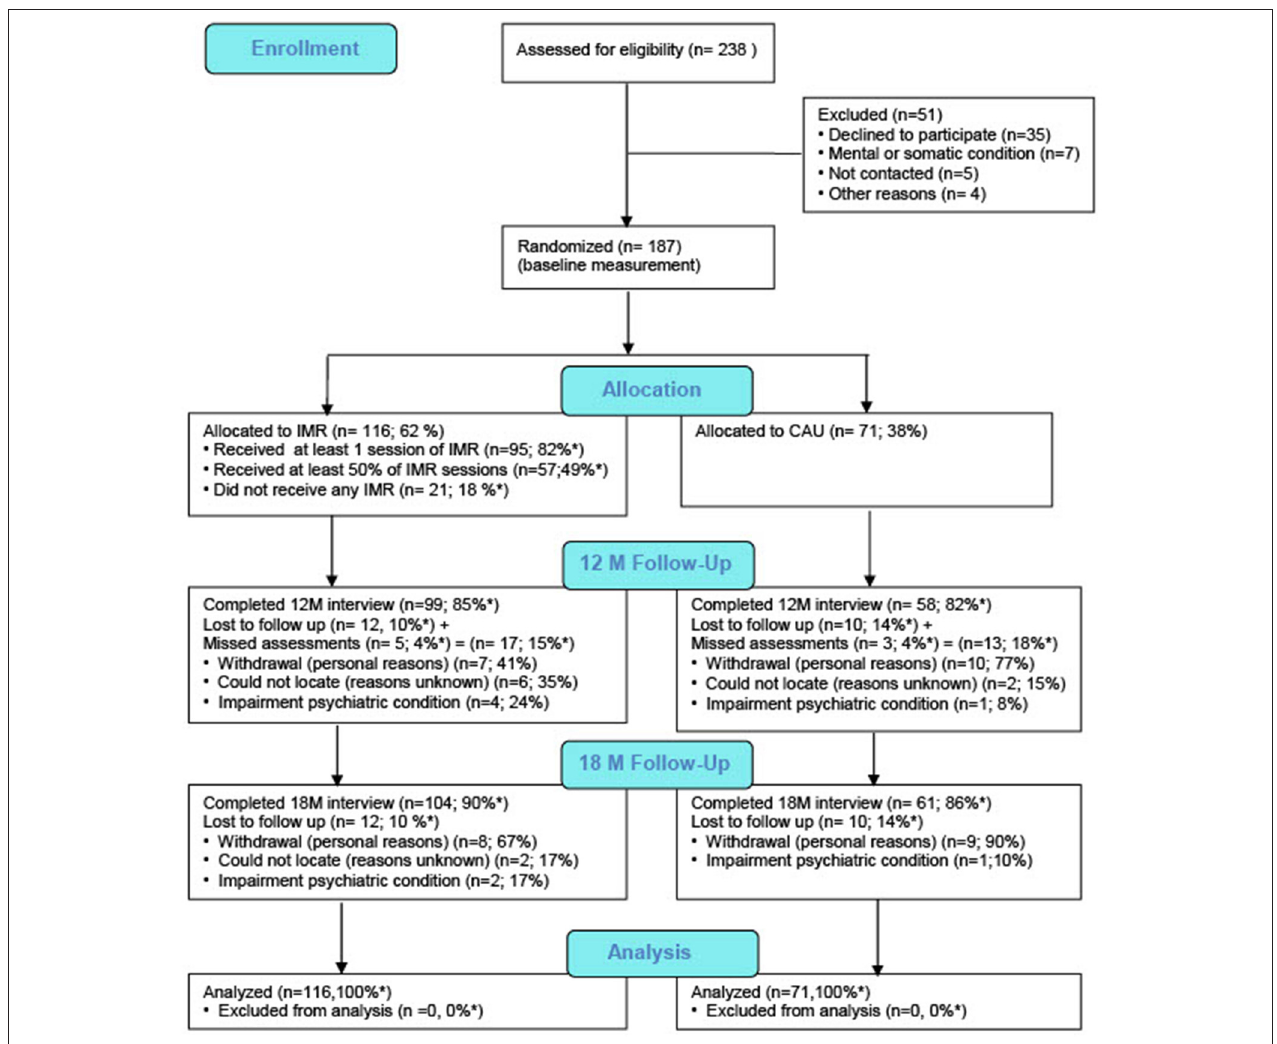
FIGURE 2 | CONSORT Flowchart. *Percentage of participants allocated to